Question: Express in one sentence what the figure is showing.
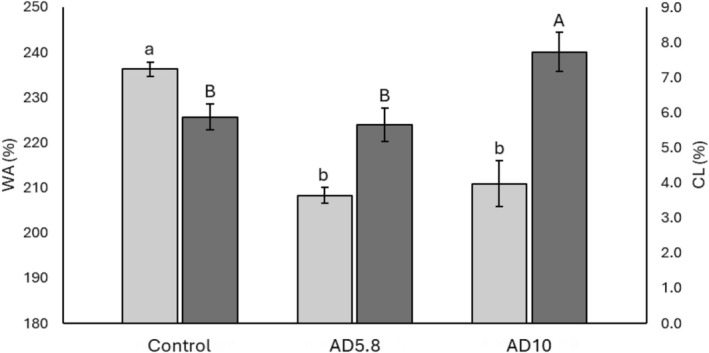
Answer: Water absorption and cooking loss of gluten‐free pasta. Different lowercase letters indicate significant differences for WA ( n = 3; p < 0.05); different capital letters indicate significant differences for CL ( n = 3; p < 0.05).